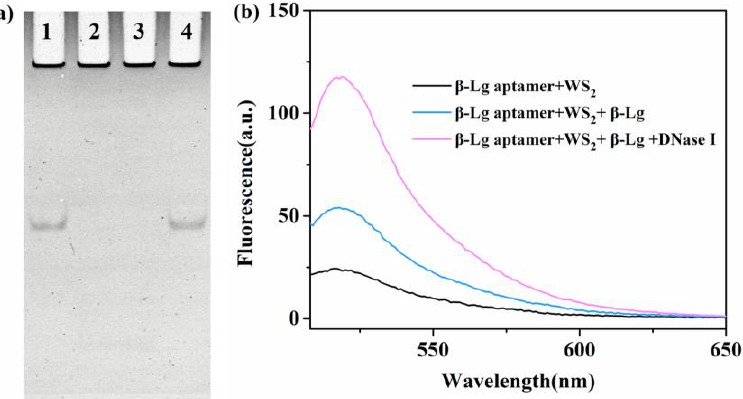
Figure 2. ( a ) Gel electrophoresis of the β-Lg aptamer. Lane 1: β-Lg aptamer; lane 2: β-Lg aptamer + DNase I; lane 3: β-Lg aptamer + β-Lg + DNase I; lane 4: β-Lg aptamer + WS 2 + DNase I. ( b ) Fluorescence spectra of β-Lg aptamer in different cases: (black line) β-Lg aptamer + WS 2 ; (blue line) β-Lg aptamer + WS 2 + β-Lg; (pink line) β-Lg aptamer + WS 2 + β-Lg + DNase I.